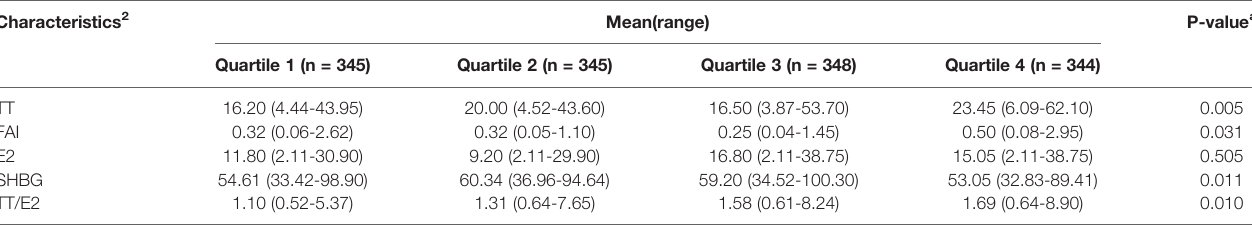
TABLE 2 | Distribution of sex hormones in different DII quantiles 1 . Characteristics 2